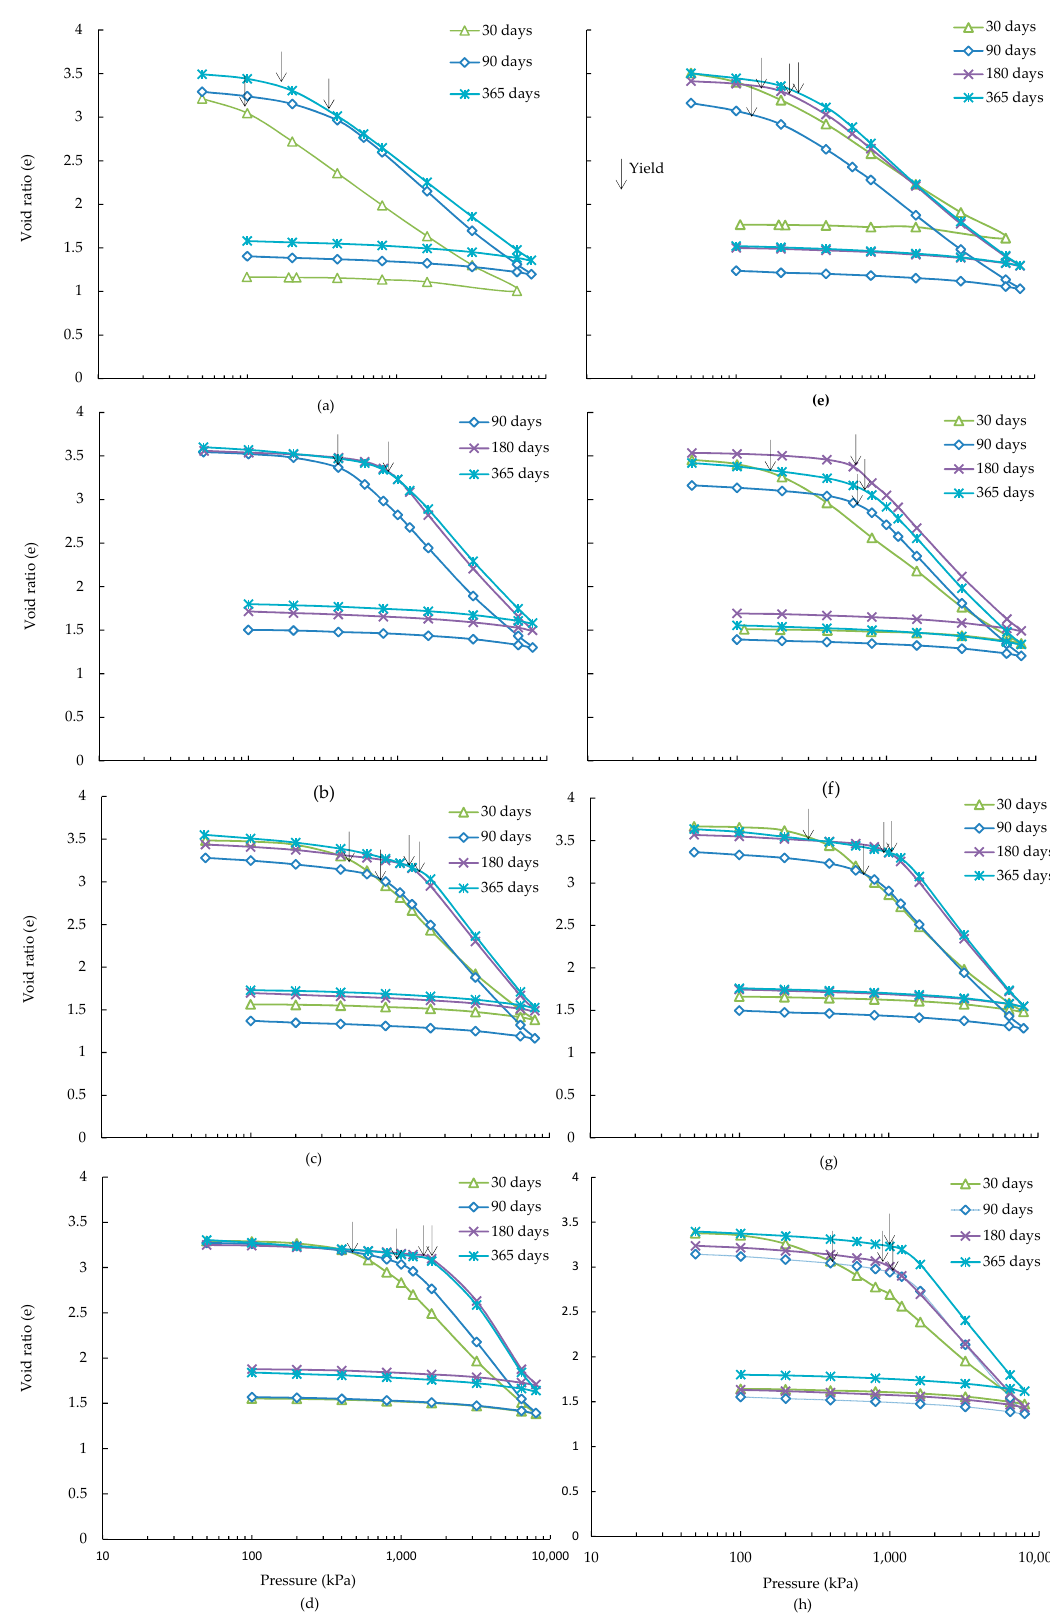
Figure 1. e-log σ′ curves for ASS treated with alkali activated ( a ) 5% slag; ( b ) 10% slag; ( c ) 15% slag; ( d ) 20% slag and for ASS containing 4% additional pyrite and treated with alkali activated ( e ) 5% slag; ( f ) 10% slag; ( g ) 15% slag; ( h ) 20% slag.